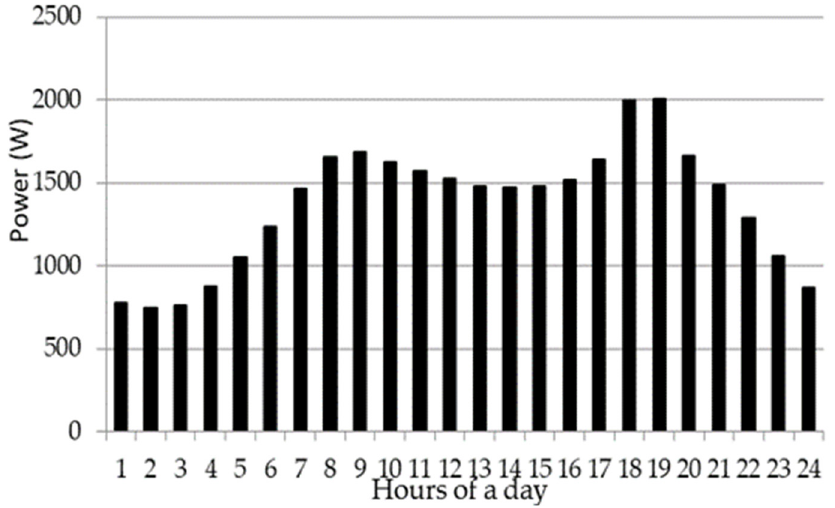
Figure 2. Hourly load demand for a home in a day during summer.